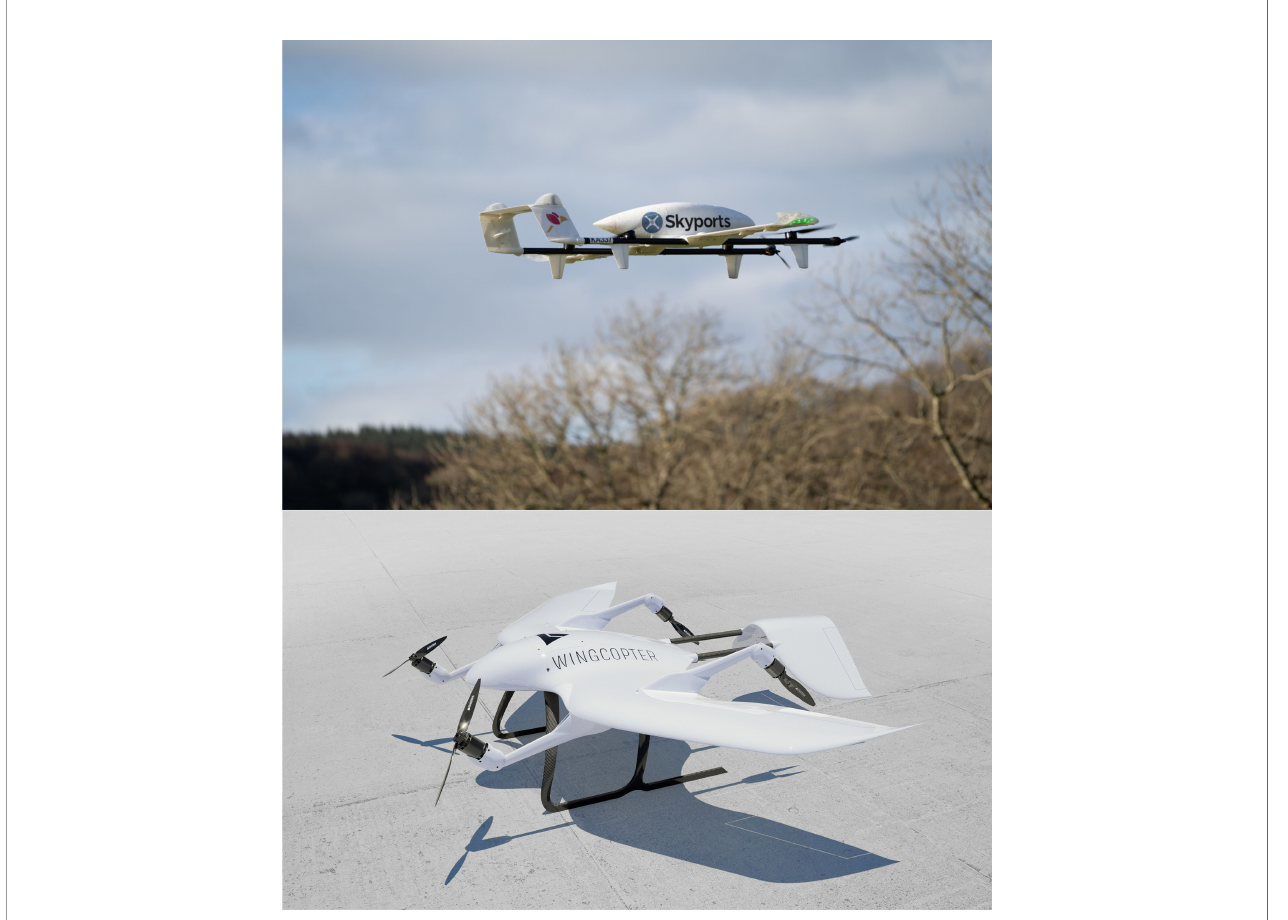
FIGURE 9 | The Skyports aircraft (Wingcopter VTOL winged aircraft) showing the swivel-mounted forward motors in take-off/landing mode. The under-slung payload ‘ pod ’ is visible. Reproduced with permission of